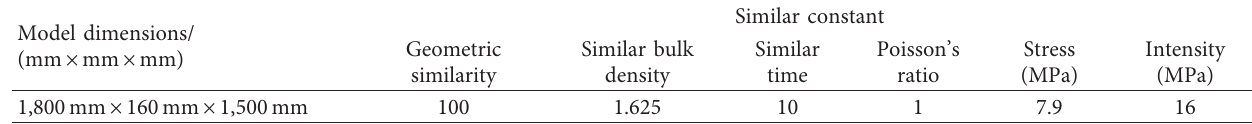
Table 1: Main similar constants of the simulation test.